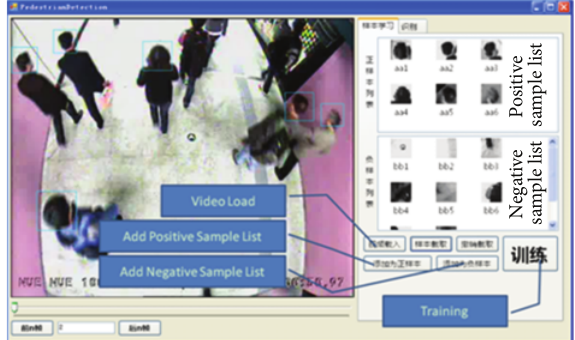
Figure 2: Short-shot and nondirect downward view.